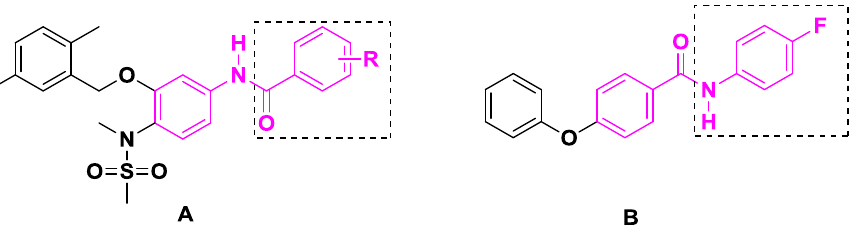
Figure 2. Structures of some benzanilide. ( A ) compounds reported by Su group. ( B ) compounds reported by Yang et al.